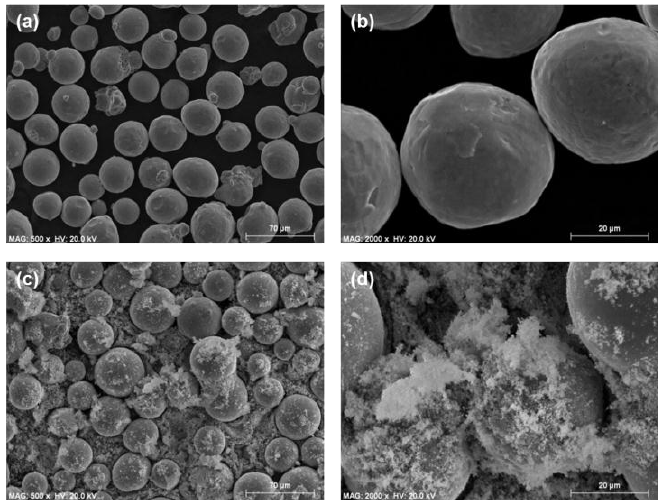
Figure 3. SEM images of the stainless steel 316L powders ( a ) before and ( c ) after RF plasma treatment; ( b , d ) their magnified